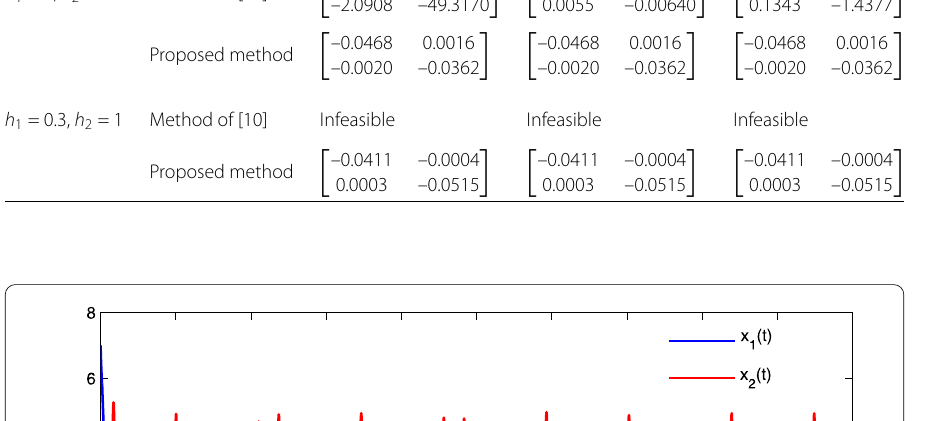
Table 1 Comparison of the feedback controller gain matrix Delay Method Controller gain matrix K 1 K 2 K 3 h 1 = 0, h 2 = 0.9